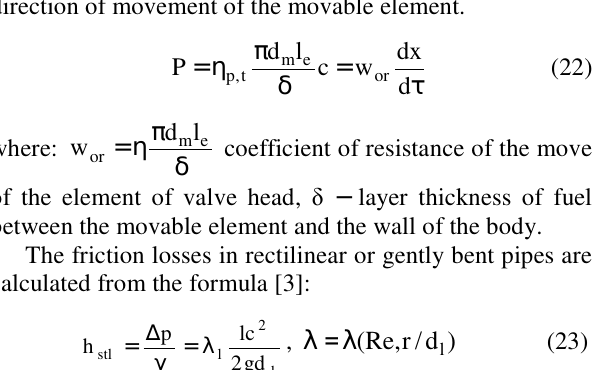
Fig. 9. Change of the fuel density of r p,t depending on the pressure and the temperature The kinematic viscosity can be calculated from the rela- tion: